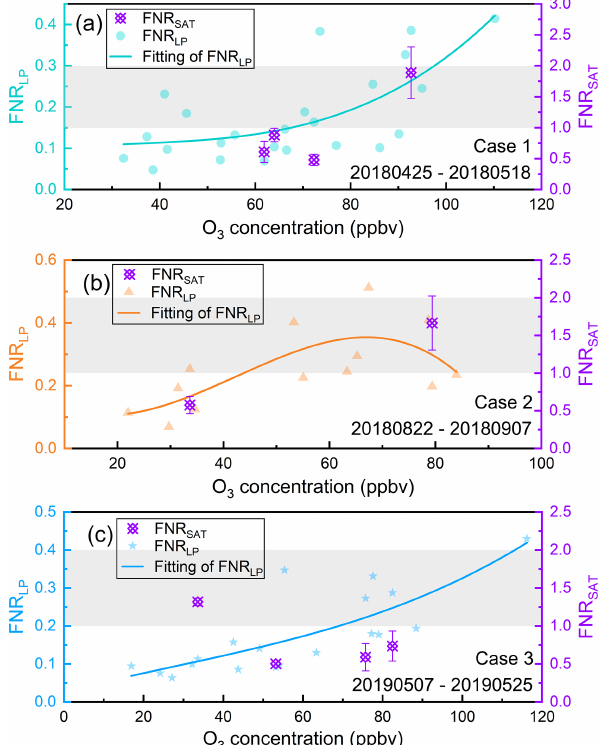
Figure 9. Comparison of FNR SAT and FNR LP in three O 3 pollution cases. The curves are polynomial fit of FNR LP , and the points are FNR SAT in corresponding cases; the gray area indicates the transi- tional regime for FNR SAT . Only LP-DOAS-measured data between 08:00–18:00LT were used.